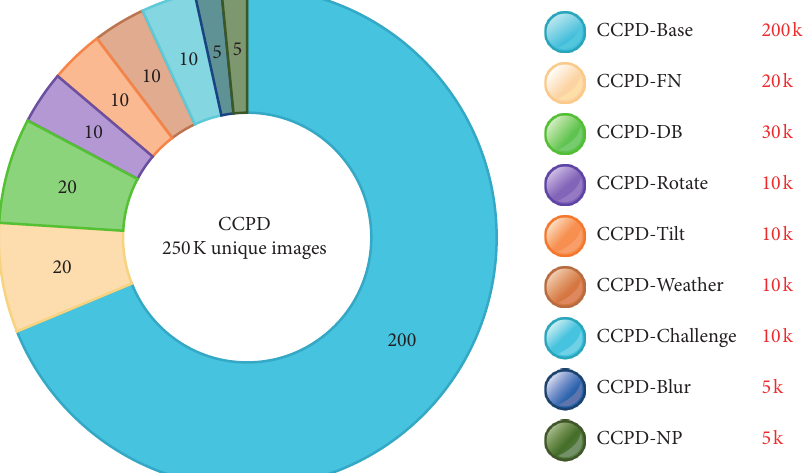
Figure 13: CCPD dataset layout [14].